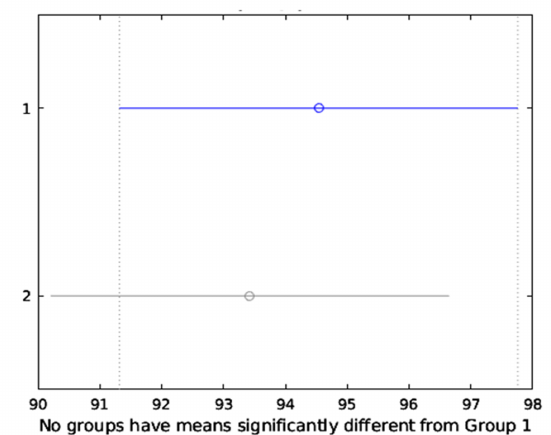
Figure 11. The means of both classifiers belong to a single group and are not significantly